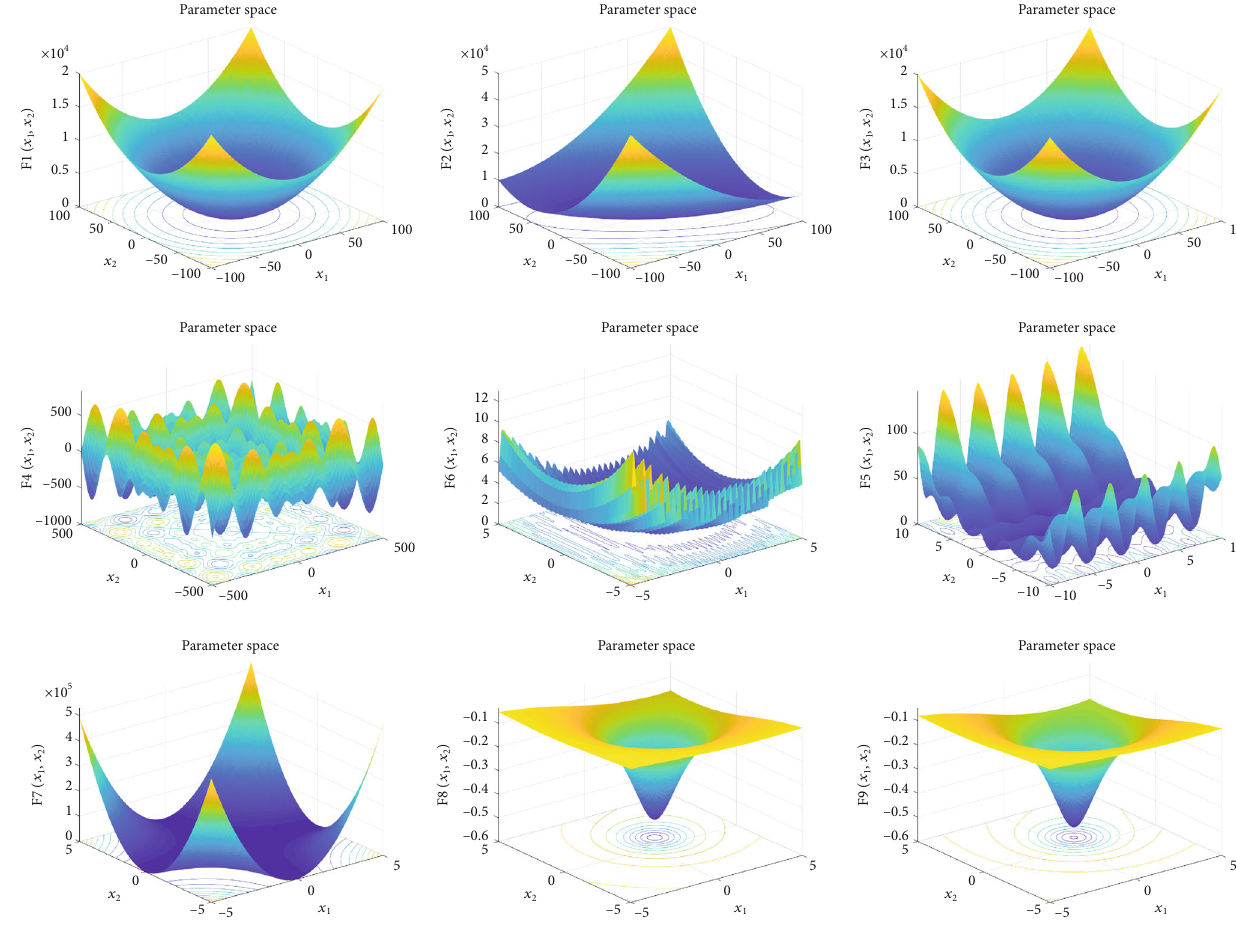
Figure 5: Function diagram. Table 2: Algorithm parameter